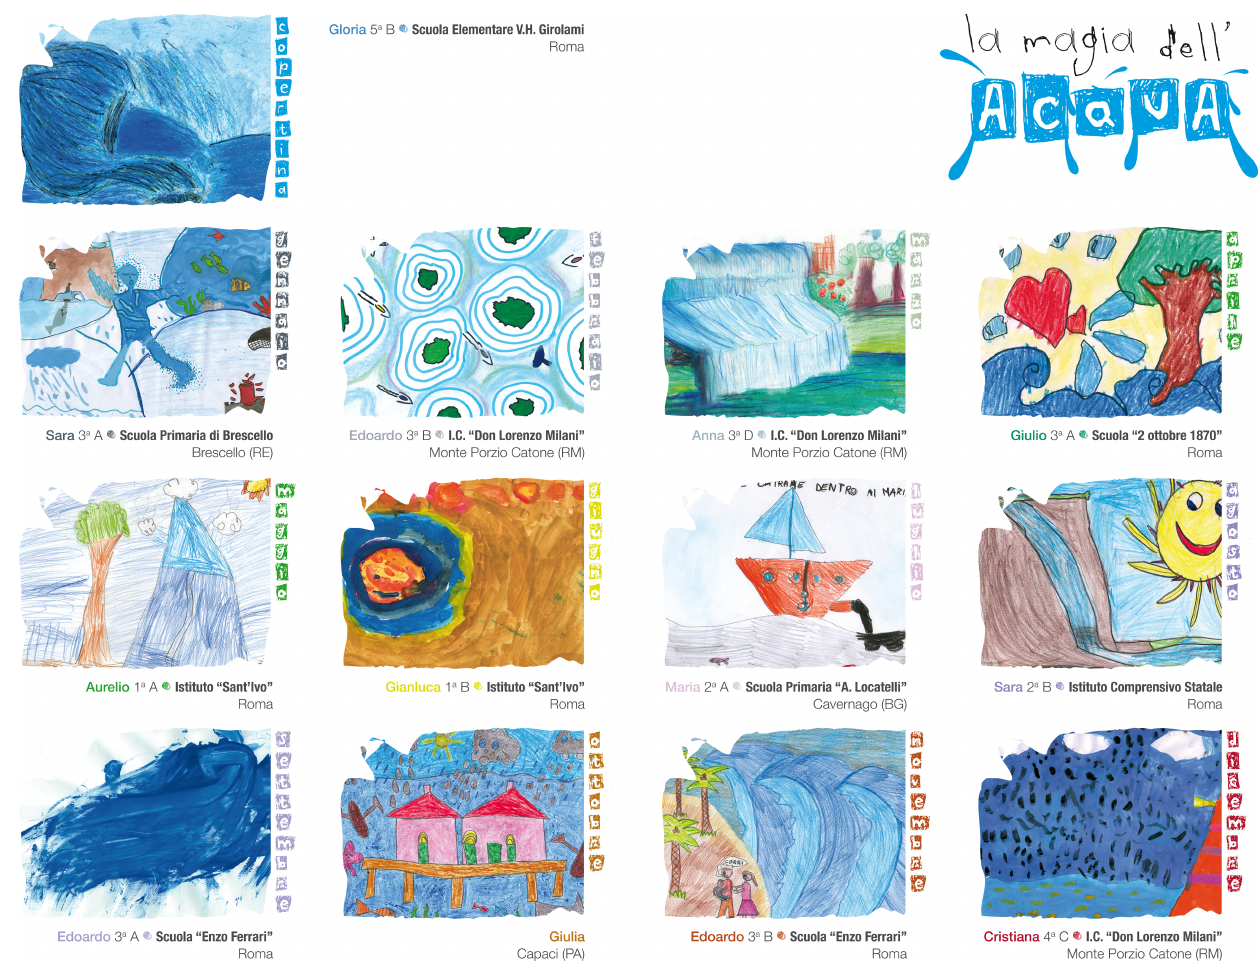
Figure 6. The back page of the 2014 calendar dedicated to water (edited by INGV Laboratorio Didattica e Divulgazione Scientifica and INGV Laboratorio Grafica e